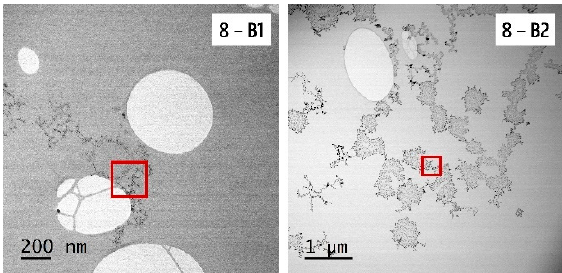
Figure 10. Representative STEM images of batch 1 and 2 of product 8. Zoom and EDX of the red square can be found in Figure 11.